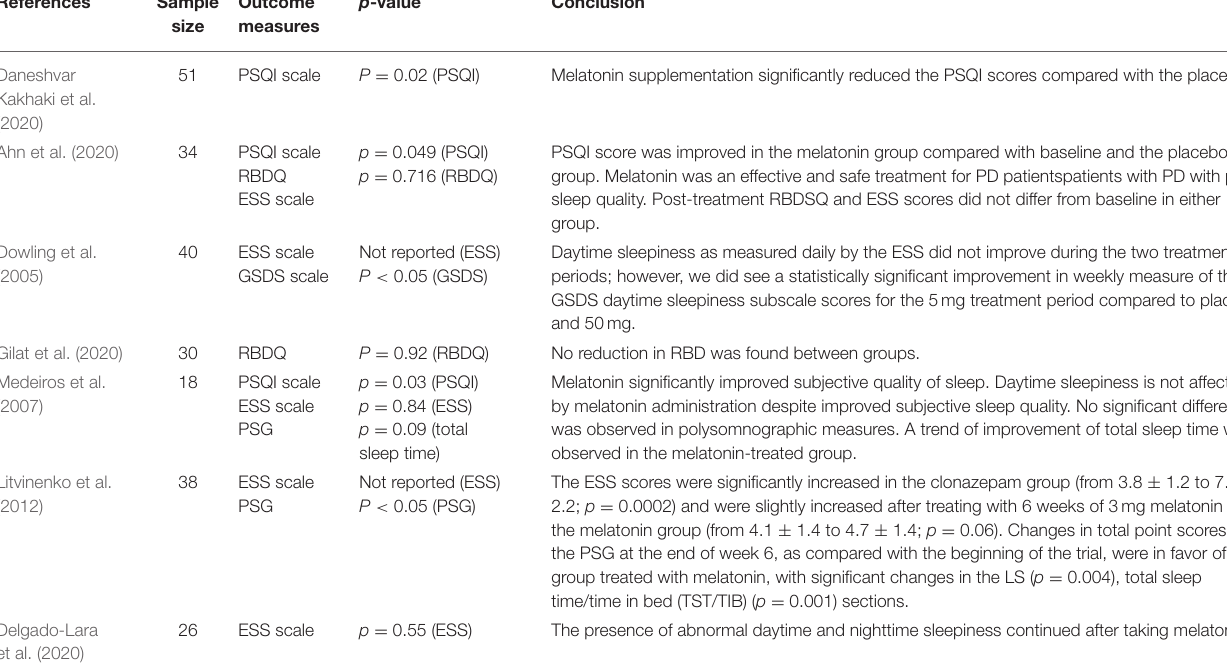
TABLE 2 | Effect of melatonin vs. placebo on sleep disorders in Parkinson’s